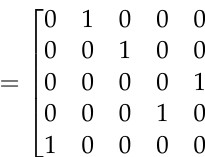
( the green line in